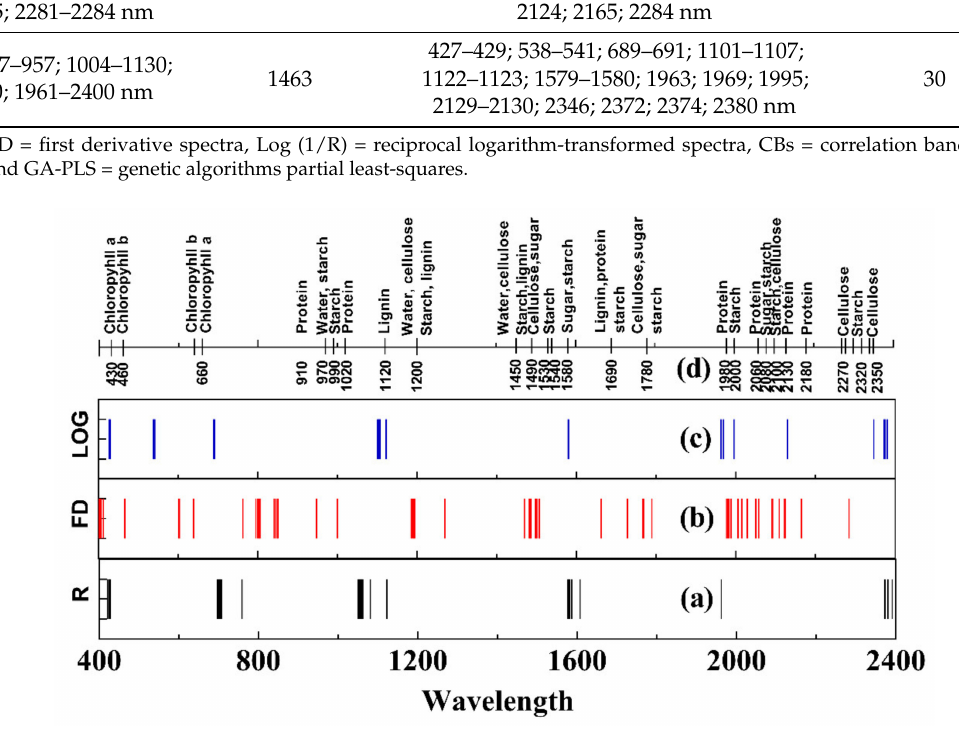
Figure 5. Important bands (IBs) selection based on reflectance spectra (R-IBs) ( a ), first derivative spectra (FD) ( b ), and reciprocal logarithm-transformed spectra (LOG) ( c ) using the genetic algorithms partial least-squares (GA-PLS). Some IBs and their corresponding absorption features [59–61] ( d